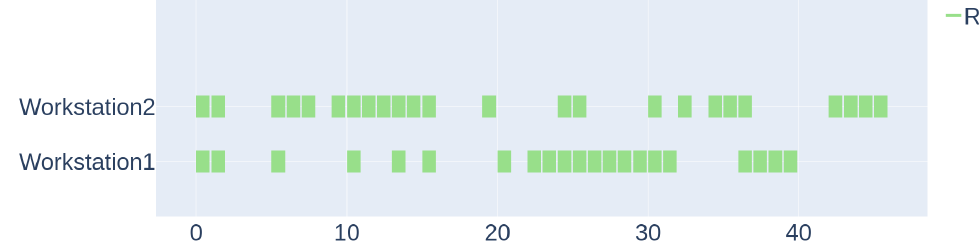
Figure 6. Scenario 1: level of resource at the workstations.